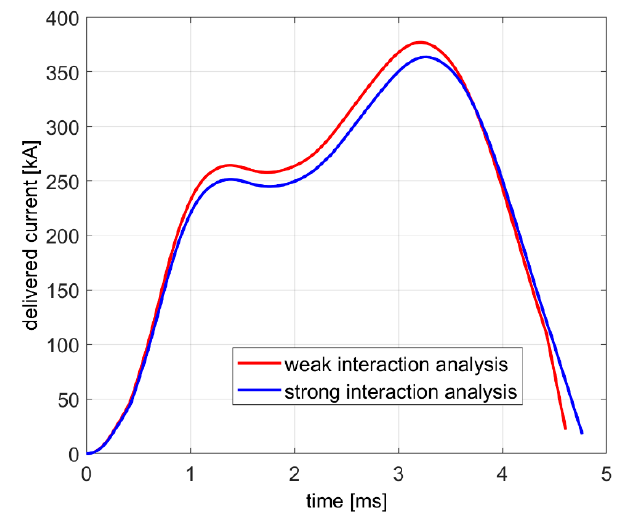
Figure 11. Time waveforms of the current delivered by the compulsator to the launcher in the strong and weak interaction. Appl. Sci. 2020 , 10 , x FOR PEER REVIEW